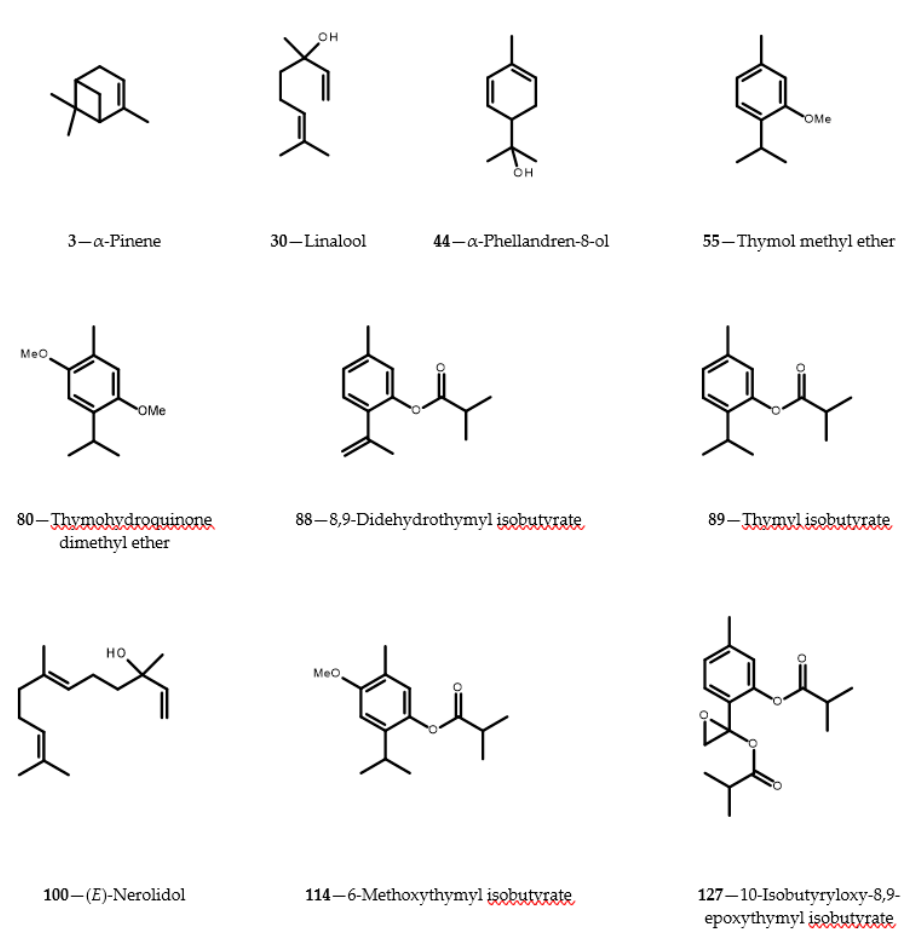
derivatives ( 55 , 88 , 89 , 114 , 115 , 120 , 121 , 123 , 126 , 127 and 129 ) it accounted for about 88% of the oil. Structure of one component of the root essential oil remained unresolved.